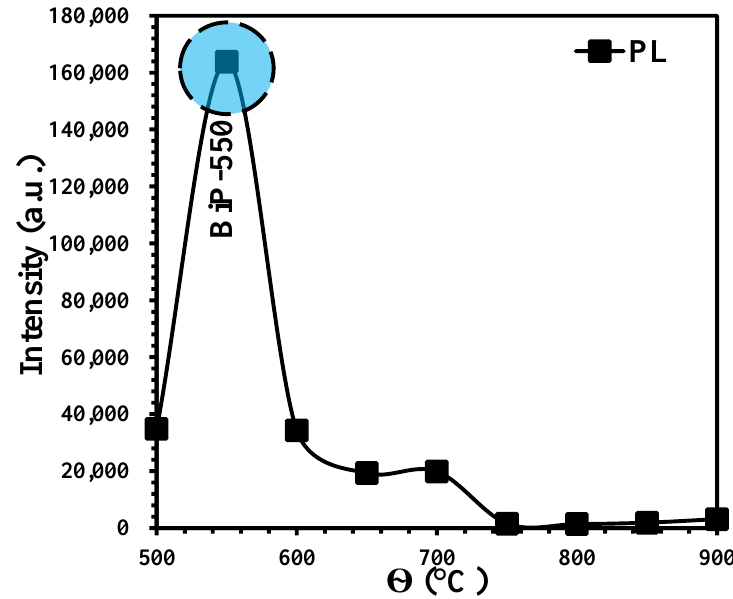
Figure 9. Variation of intensity of BiP-Θ samples with elaboration temperature.